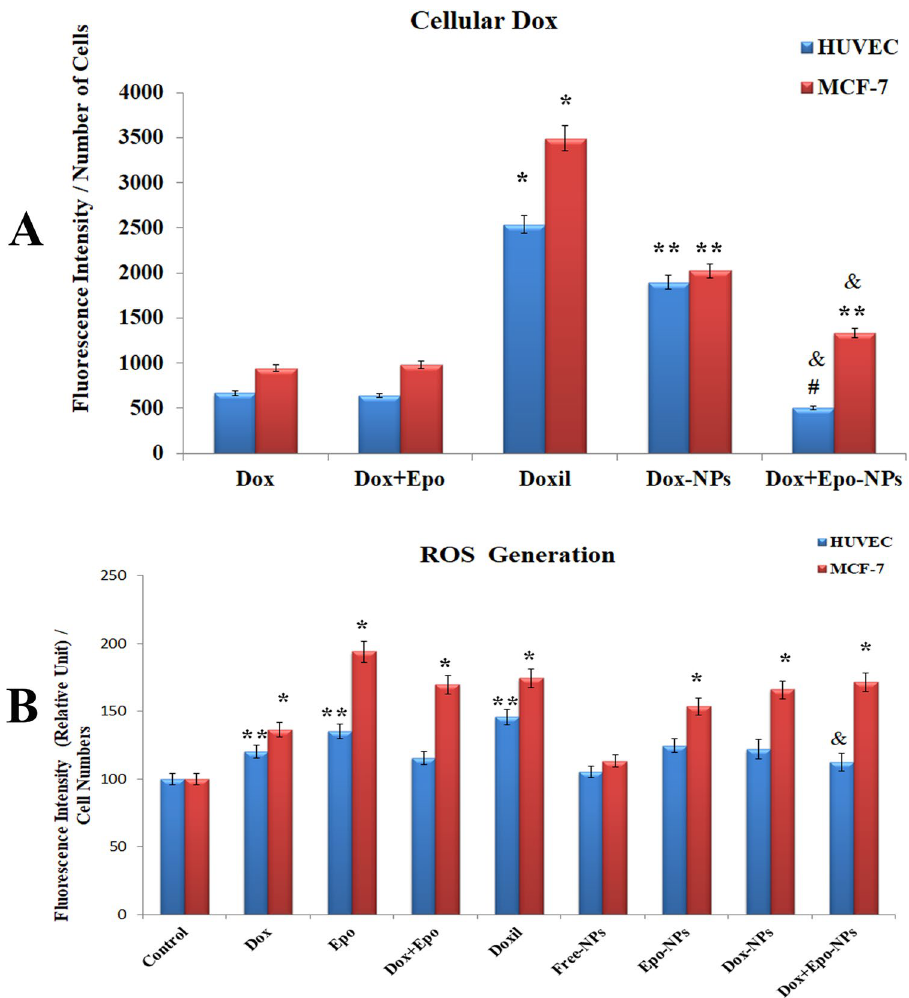
Figure 5. (A) Amounts of Dox in the nine HUVECs and MCF-7 cell groups incubated for 6 h (n = 3 in each experiment). Values are mean ± SD. *Values significantly different from all groups in the HUVECs and MCF-7 cells p < 0.001. **Values significantly different from all groups in the HUVECs and MCF-7 cells p < 0.01. & Values significantly different from all groups in the HUVECs and MCF-7 cells p < 0.01. # Values significantly different from all groups in the HUVECs p < 0.001. ( B) Measurement of the ROS Generation in the nine HUVECs and MCF-7 cell groups incubated for 18 h (n = 3 in each experiment). Values are mean ± SD. *Values significantly different from control, free Epo, free Dox + Epo and all NPs groups in HUVECs p < 0.001. **Values significantly different from control, free-NPs, and Dox + Epo-NPs groups in HUVECs p < 0.01. & Values significantly different from free Dox, free Epo, DOXIL in the HUVECs and MCF-7 cells p <